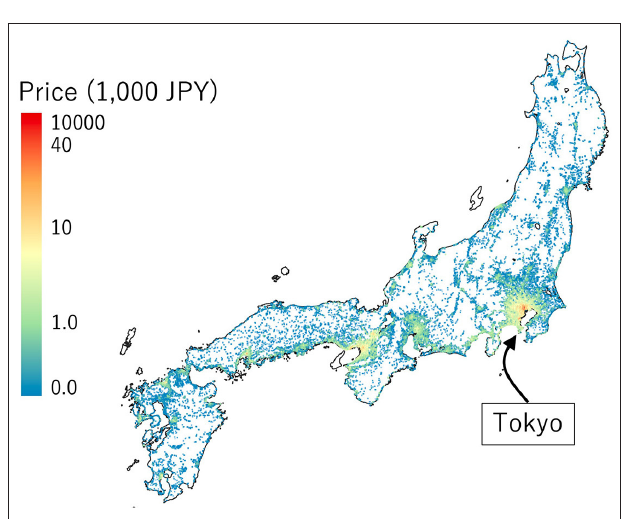
FIGURE 2 | Spatial distribution of the residential land price per area